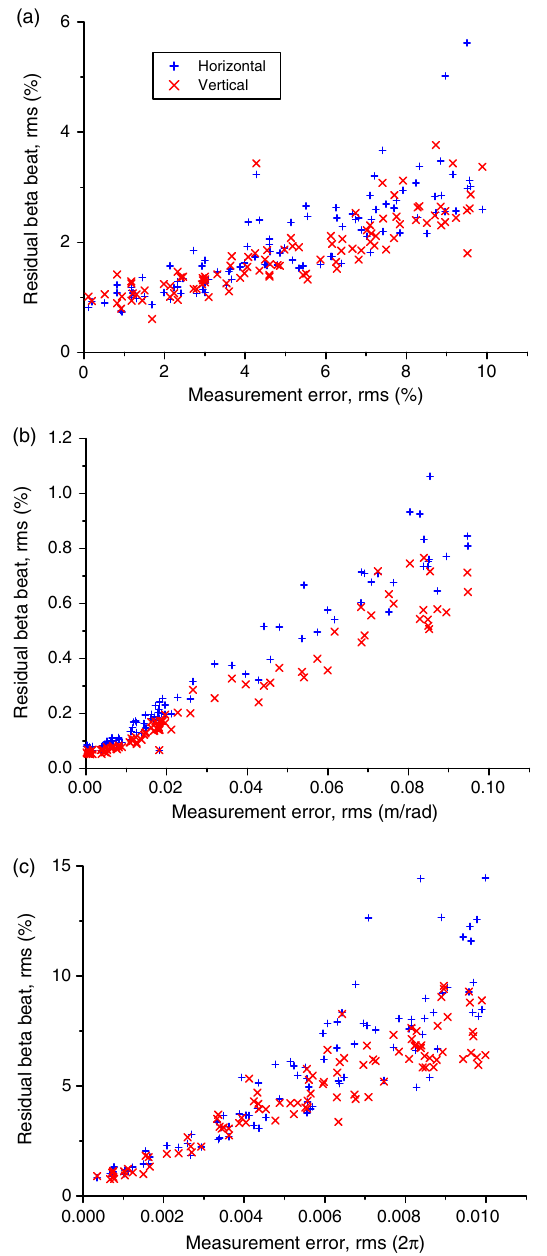
FIG. 11. Residual beta-beat at the end of iteration vs measure- ment error (simulation) for (a) QV, (b) LOCO, and (c)